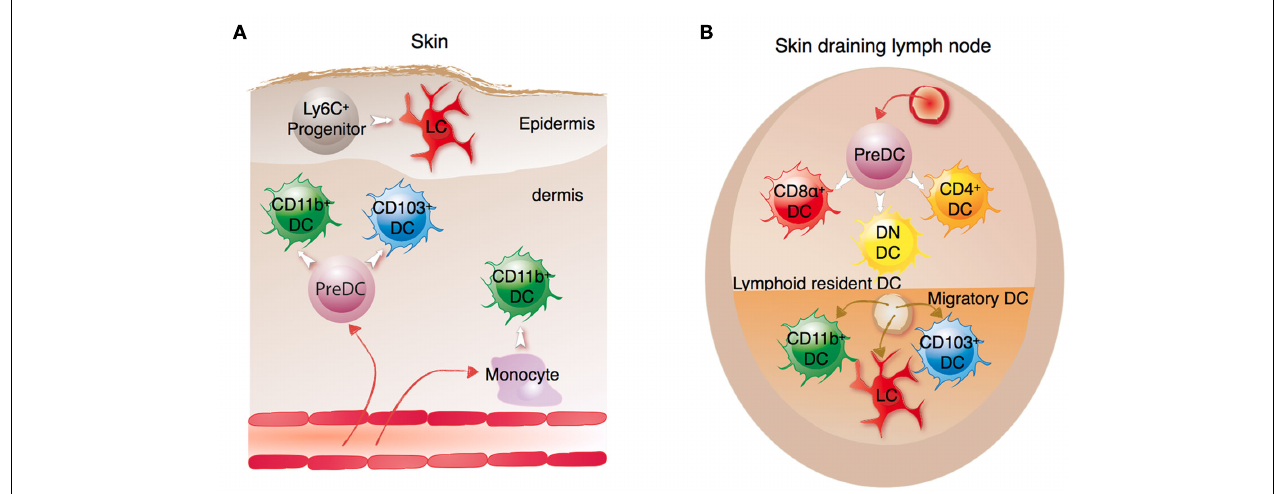
FIGURE 1 |Architecture of the DC network. The DC network is composed of multiple DC subsets that are broadly divided into cDCs, pDCs, MoDCs, and LCs which have distinct anatomical localizations in tissues. (A) Migratory DCs in peripheral tissues sample antigen from the periphery and then migrate through the lymphatic vessels to the afferent lymph node to present captured-processed antigens to theT cell within theT cell zone. In peripheral tissues, such as the skin, three main DC subsets are found. Dermal DCs are composed of the CD103 + CD11b − DC and CD11b + DC. Both arise from a